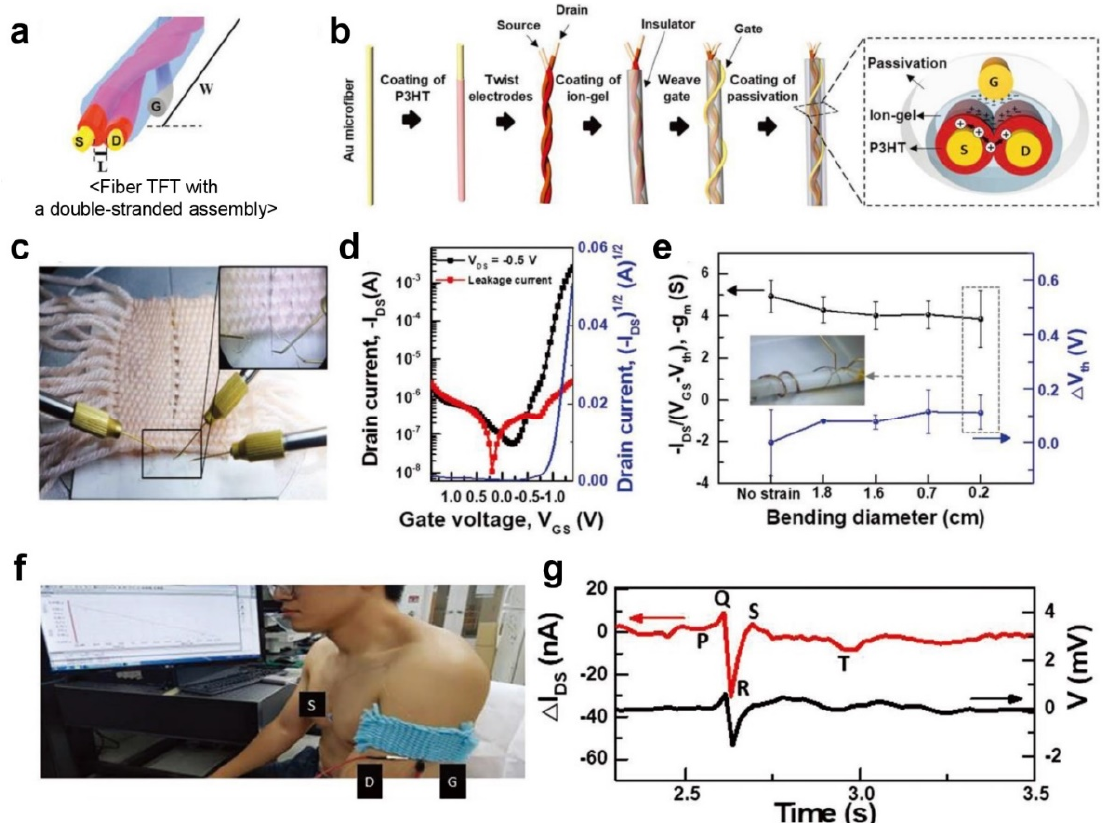
Figure 13. ( a ) Schematic illustration of a fiber OFET with a double-stranded assembly. ( b ) Schematic illustration of the fabrication process of the fiber OFET. ( c ) Photograph of the fiber OFETs embedded in the textile. ( d ) Transfer characteristic of the OFET. ( e ) Change in transconductance and threshold voltage according to bending diameter. ( f ) A photograph of a human subject wearing the fiber OFETs embedded in the textile for the measurement of ECG signal. ( g ) Single ECG trace from potentiometric recording (black line) and drain current (red line) from the fiber OFETs. Reprinted from [73], copyright 2019 with permission from John Wiley and Sons.